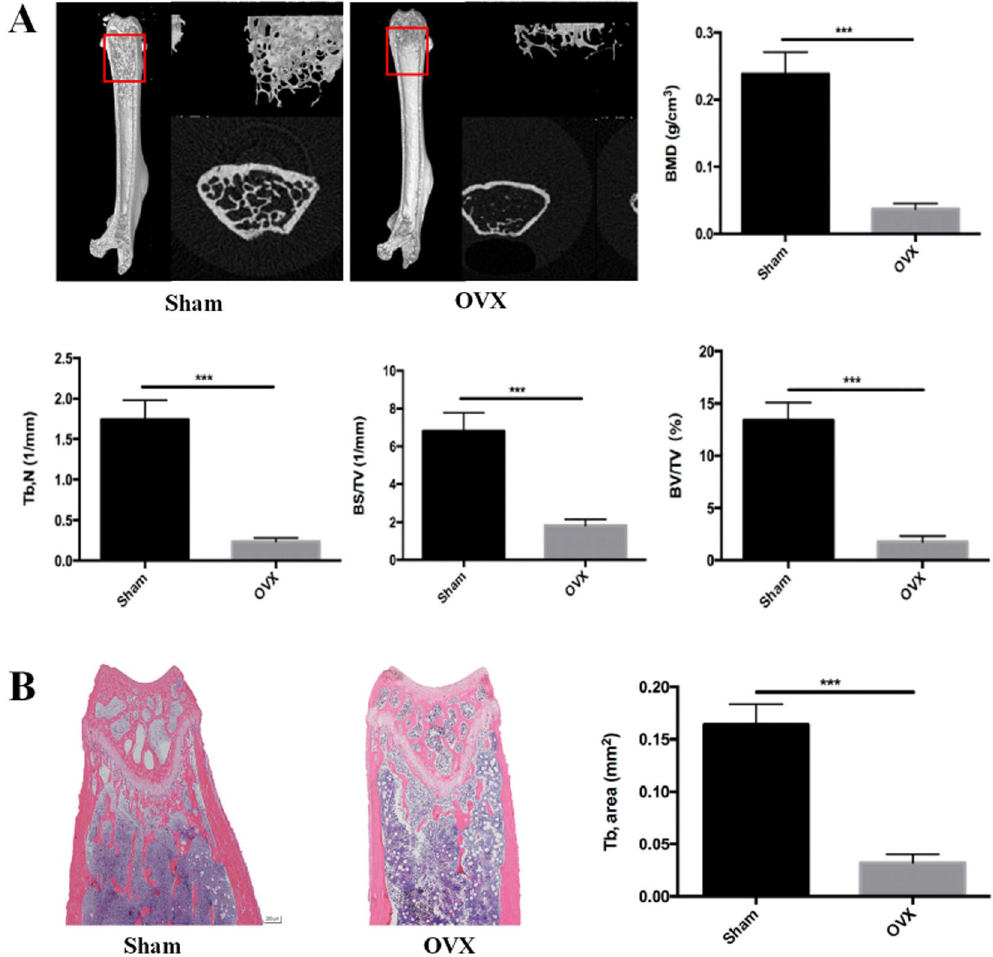
Figure 1. Ovariectomy-induced bone loss in vivo . ( A ) Micro CT analysis of the distal femur from sham and OVX group. Calculations of bone mineral density (BMD), trabecular number (Tb, N), bone surface area/ total value (BS/TV), bone value/total value (BV/TV). ( B ) H&E staining of distal femoral sections and quantification of trabecular area from sham and OVX group. ( *** P <